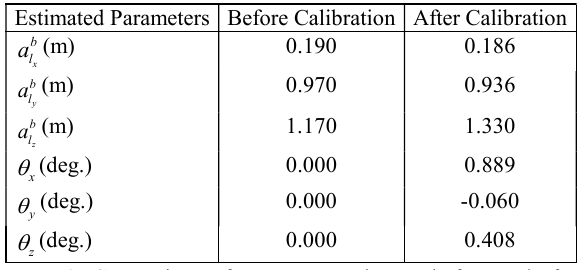
Table 3 . Comparison of parameter estimates before and after